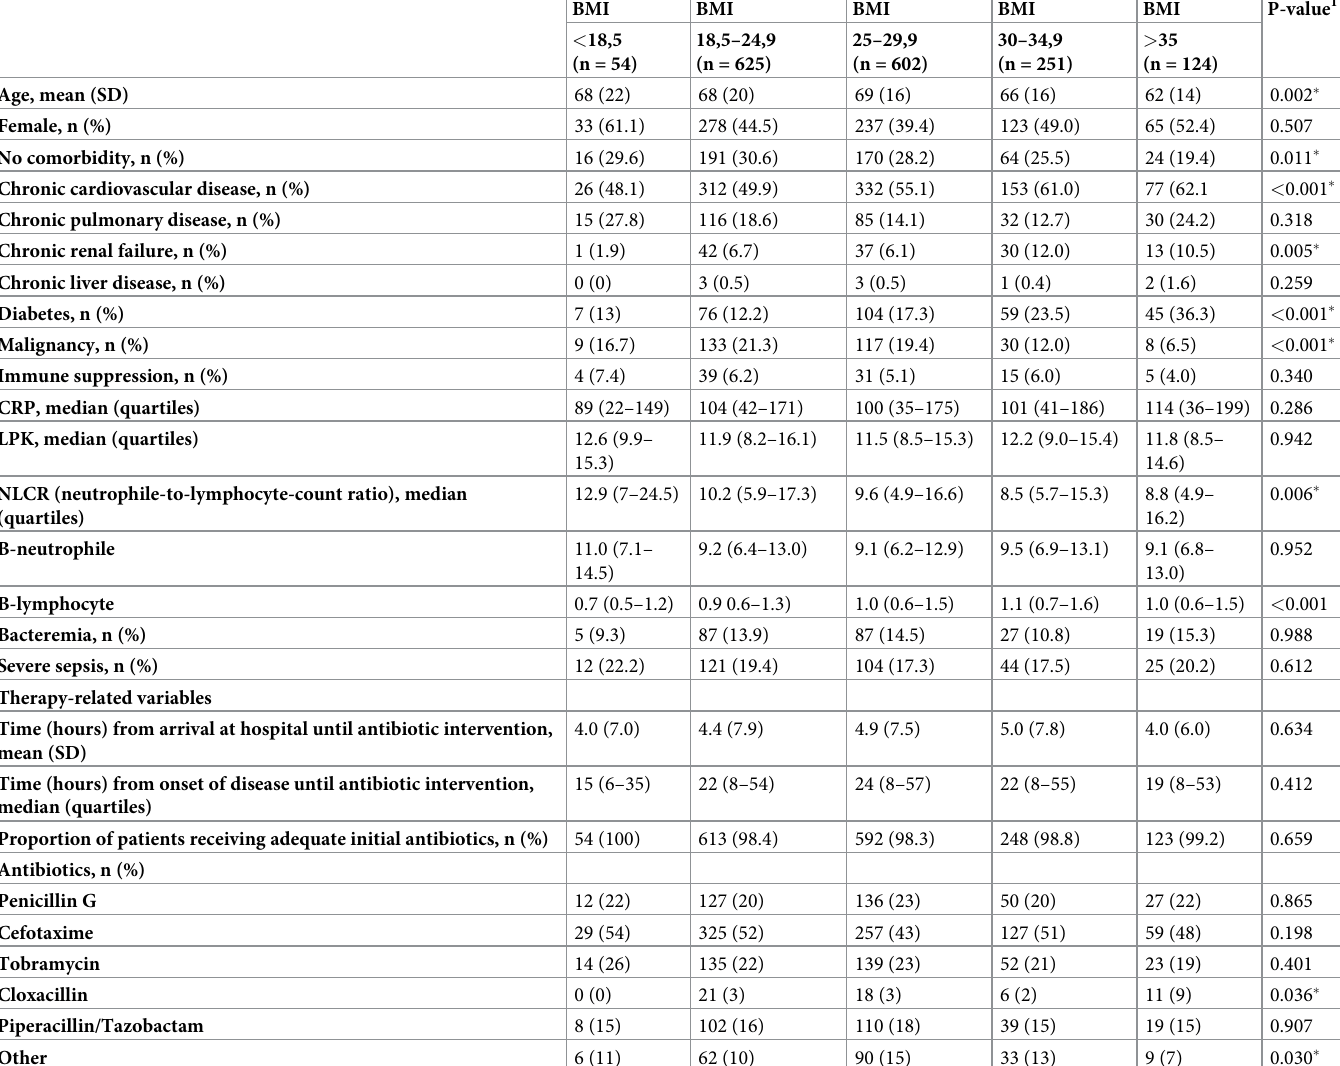
Table 1. Demographic and clinical characteristics by